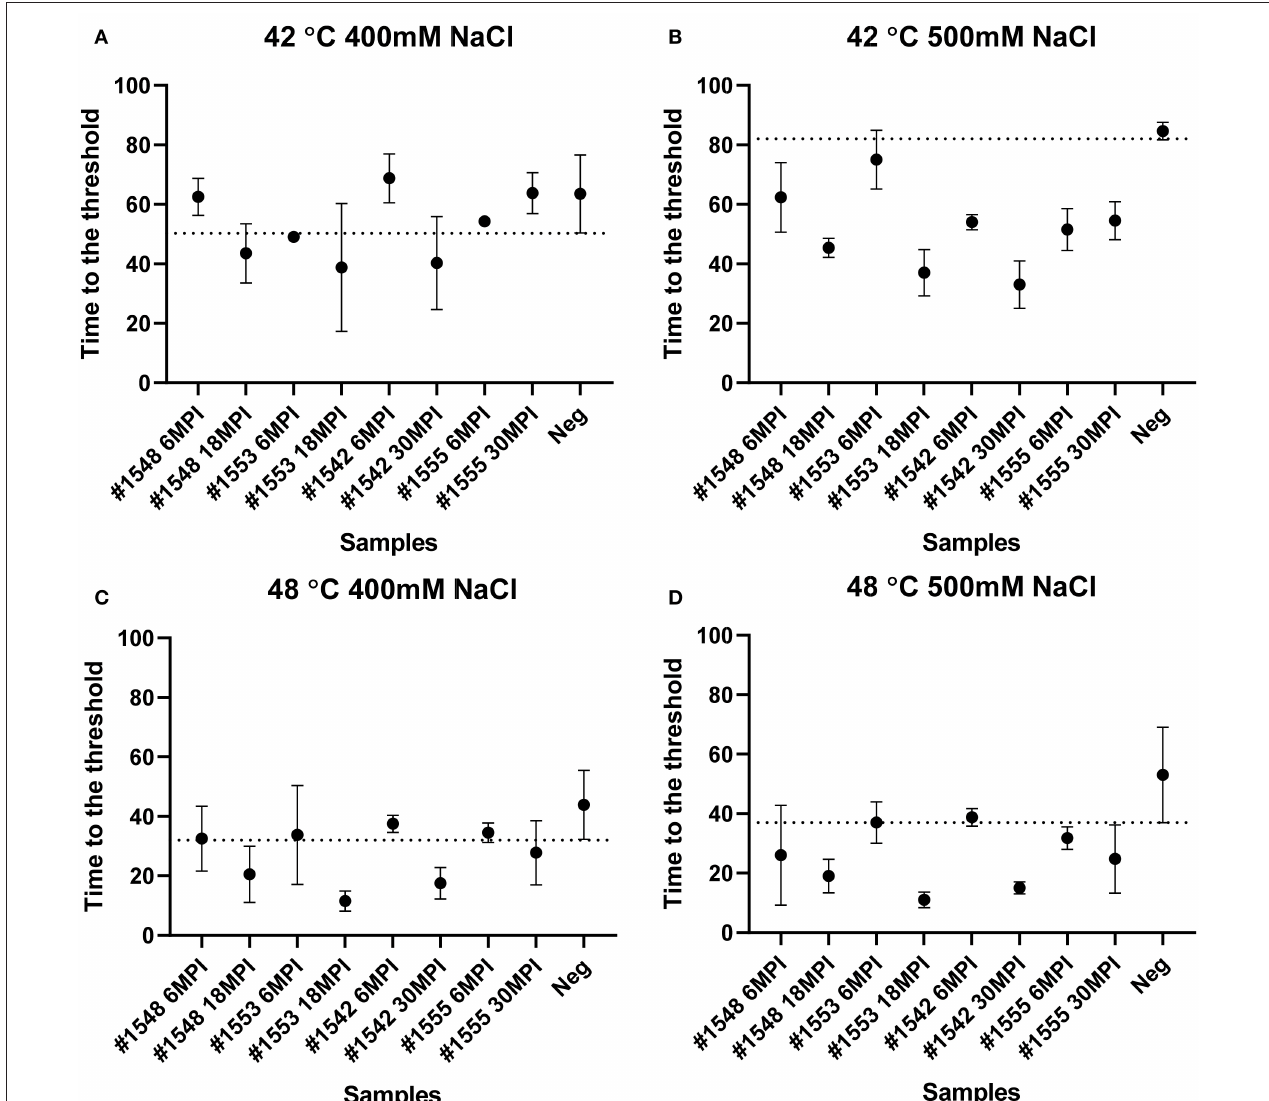
FIGURE 7 | Lag time analysis of RT-QuIC reactions seeded with biopsy fecal homogenates from preclinical white-tailed deer. Reaction conditions for each sample are followed as (A) 400mM NaCl at 42 ◦ C, (B) 500mM NaCl at 42 ◦ C, (C) 400mM NaCl at 48 ◦ C, and (D) 500mM NaCl at 48 ◦ C. Circles represent the mean and bars represent SD of four replicate reactions. The horizontal line is the